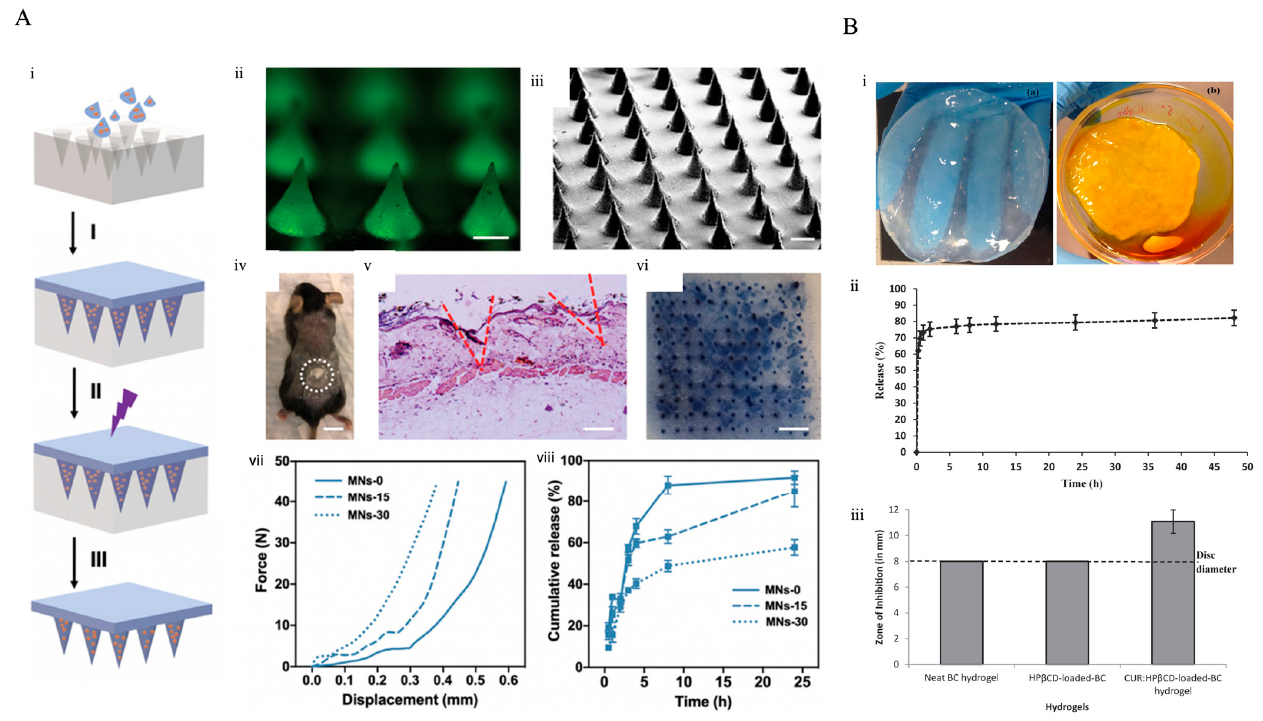
Figure 7. ( A ) Characterization of GelMA- β -CD based MNs. (i) Fabrication of MNs includes cen- trifugation, UV crosslinking and dry steps. (ii) Fluorescence display of MNs filled with curcimin which is visible with green fluorescence (Scale Bar: 200 µ m). (iii) SEM visualization of MNs (Scale Bar: 300 µ m). (iv) Transcutaneous application of the MN patch on a mouse, the closed dash circle represent the treatment site (Scale Bar: 1 cm). (v) A view of mouse skin stained with H&E demon- strating MN patch penetration (Scale Bar: 200 µ m). (vi) MN patch penetration into the skin. Skin from a mouse cadaver was stained with 0.5% Trypan Blue after MN patch was attached (Scale Bar: 2 mm). (vii) Test of mechanical strength. (viii) Release test of curcimin. Reprinted with permission from [135], copyright 2020 Wiley. ( B ) Curcimin-loaded bacterial cellulose hydrogels. (i–a) Purified bacterial cellulose hydrogel. (i–b) Curcimin-loaded bacterial cellulose. (ii) A 48 h release profile from CUR:HP β CD-filled BC hydrogels. (iii) Disc diffusion test evaluation of antimicrobial efficacy against S. aureus for clean BC, HP-loaded-BC, and CUR:HP-loaded-BC hydrogels. Reprinted with